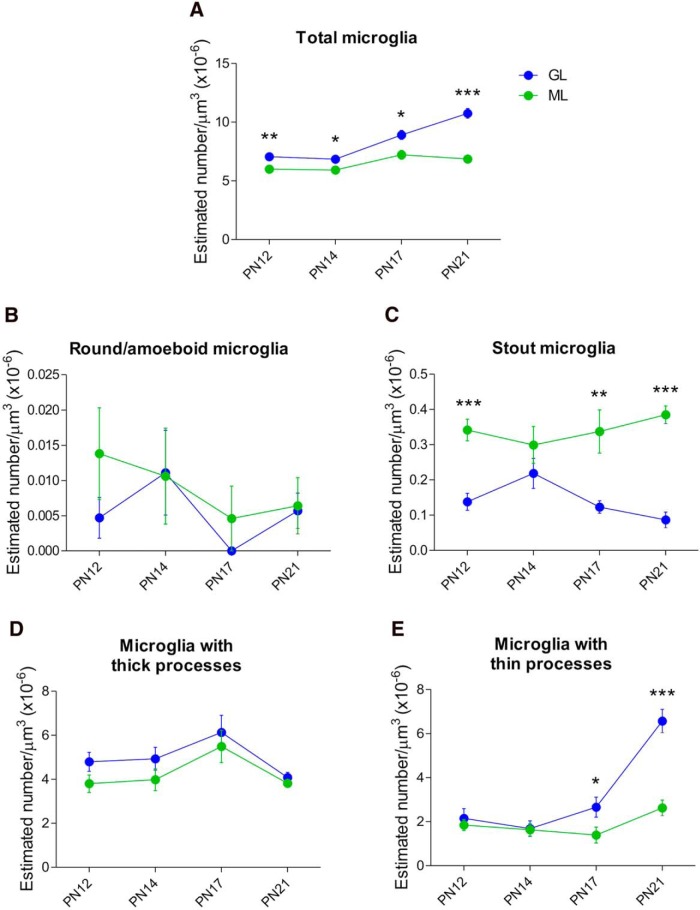
Microglia location in the cerebellar cortex based on morphological classification. A, Total microglia were significantly higher in the GL than the ML during the second and third postnatal week in the cerebellum (*p < 0.05, **p < 0.01, ***p < 0.000). B, The density of round/amoeboid microglia was very low and did not differ between the ML and the GL from P12 to P21. C, The density of stout microglia was significantly higher in the ML than the GL at all days examined except P14 (**p < 0.01, ***p < 0.000). D, Microglia with thick processes were the most abundant but did not differ between the ML and the GL. E, There were significantly more microglia with thin processes in the GL than the ML at P17 and P21 but not at younger ages examined (*p < 0.05, ***p < 0.000). All data are expressed as mean ± SEM (n = 6, 3 males + 3 females for each group).